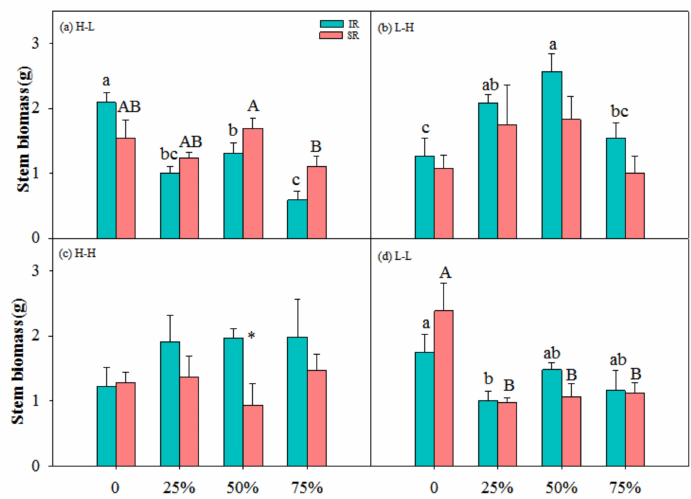
Figure 3. Stem biomass of ramets with intact rhizome (IR) and severed rhizome (SR) with increasing clipping levels in di ff erent nutrient treatments. ( a ) H-L, ( b ) L-H, ( c ) H-H and ( d ) L-L indicate high-low, low-high, high-high and low-low nutrient treatments, respectively. The error bars represent standard errors (SE), and bars with di ff erent lower-case and upper-case letters indicate significant di ff erence among clipping levels for ramets with intact and severed rhizome, respectively ( p < 0.05). *—significant di ff erence between ramets with IR vs. SR at the same clipping level.